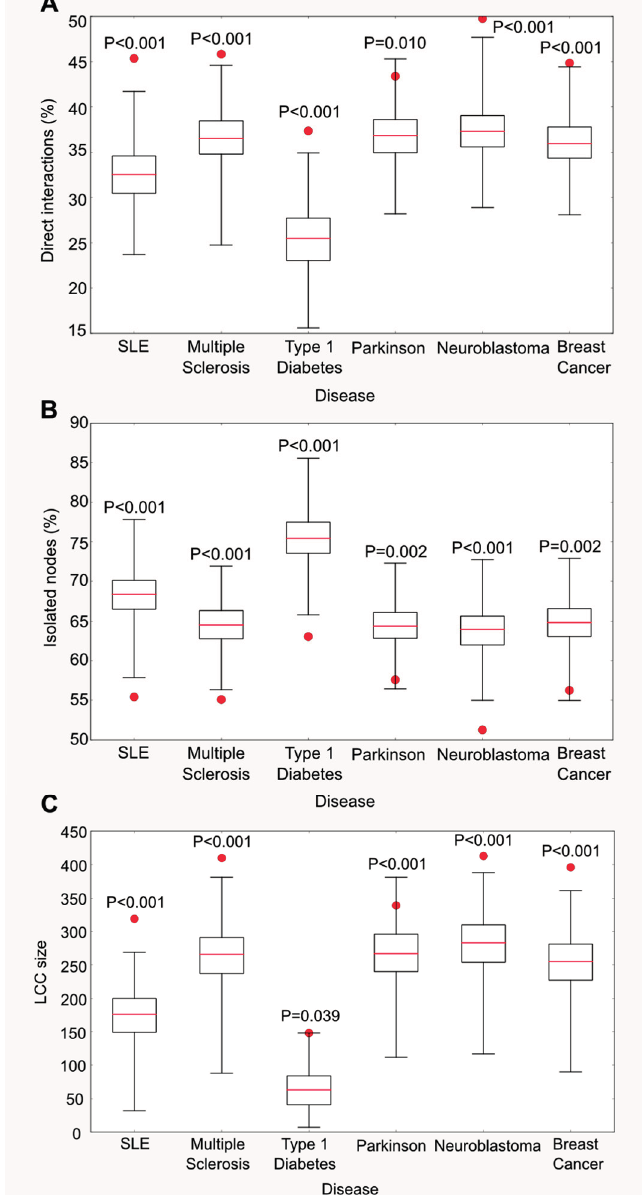
Figure 1. Proteins encoded by genes selected at –Log 10 gene-wise p -values <1 are functionally related in a protein-protein interaction (PPI). Red circles represent the real value obtained for each genome-wide association studies (GWAS) dataset analyzed. Box plots represent the percentage of direct interactions ( A ) and isolated nodes ( B ) and the largest connected component (LCC) size ( C ) in the 1000 random samples of proteins, by disease. Empirical p -values are